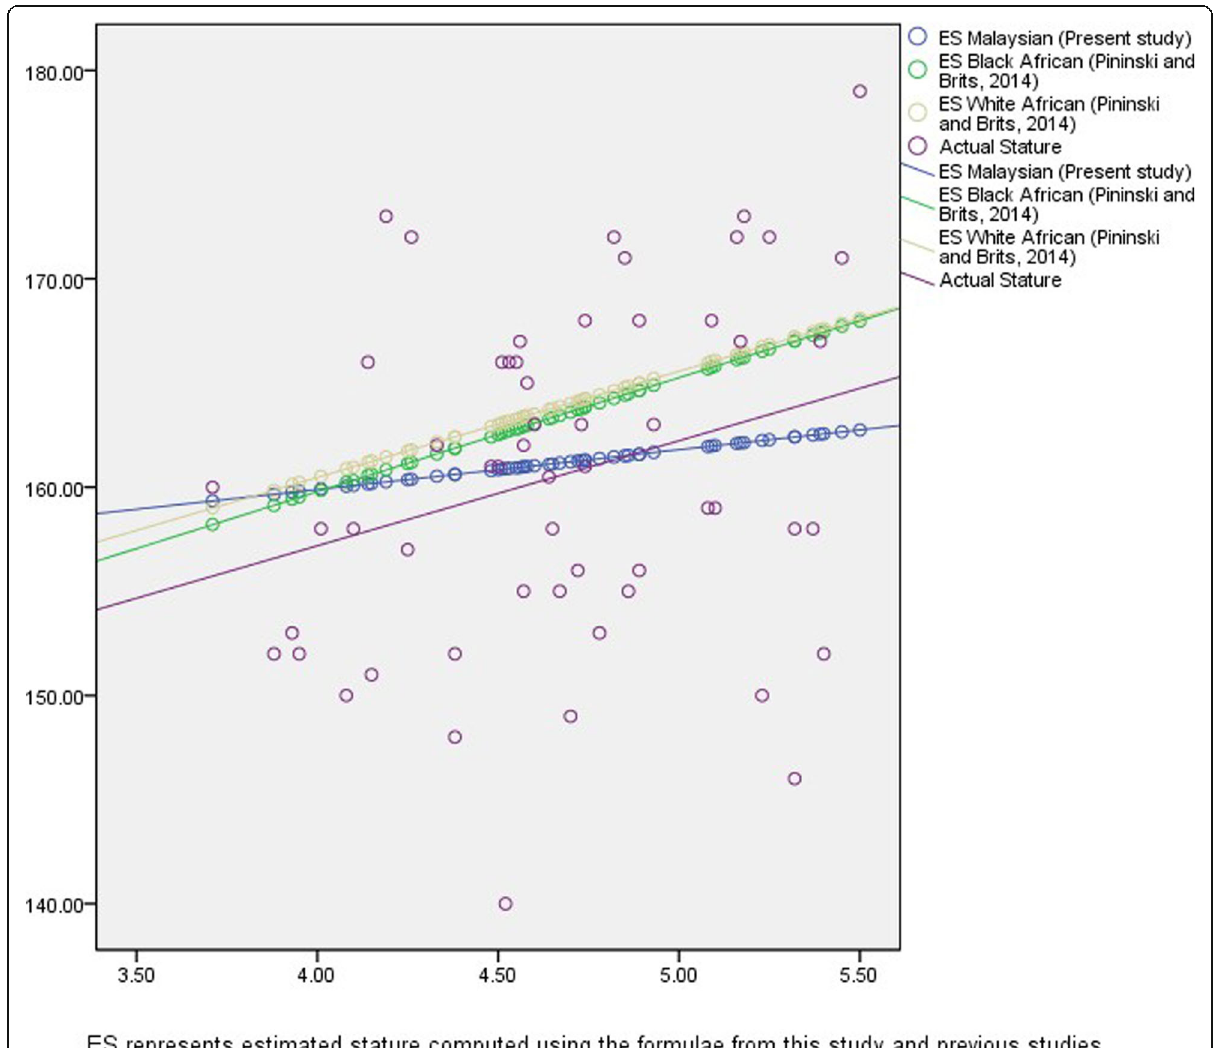
Fig. 2 Comparison of estimated stature by using formulae from different studies based on transverse diameter of S1 body (P2) correlation with actual